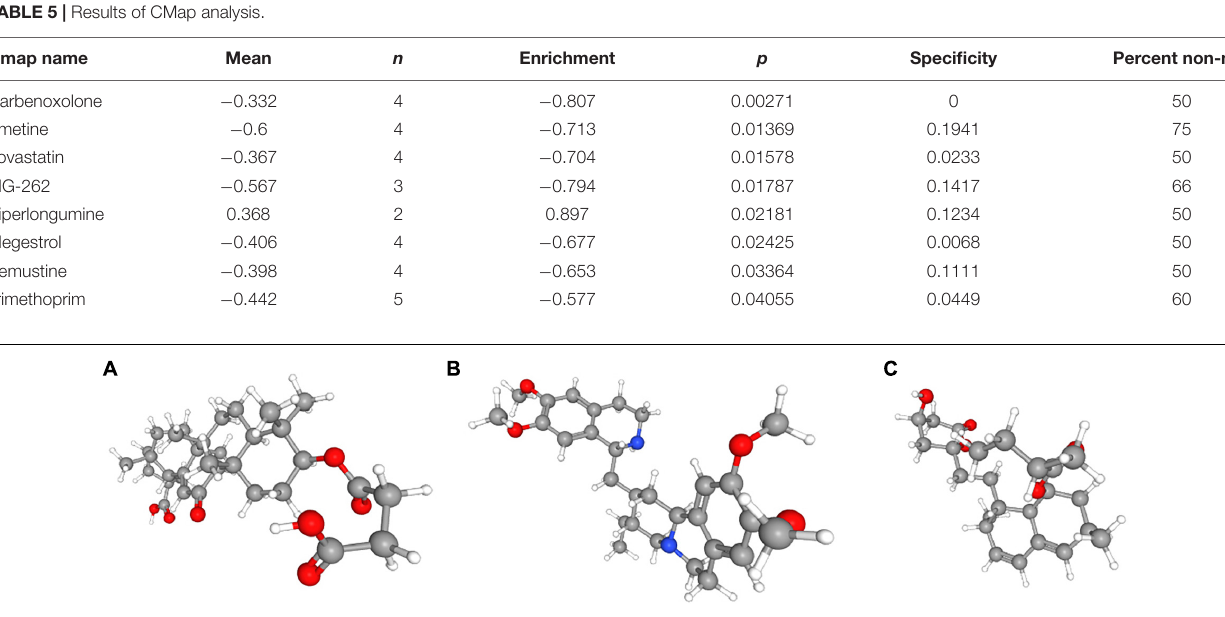
FIGURE 12 | The 3D structure of the three small molecule drugs for UCEC. (A) carbenoxolone, (B) emetine, and (C) lovastatin. (Chen et al., 2019). High TMB and high neoantigen